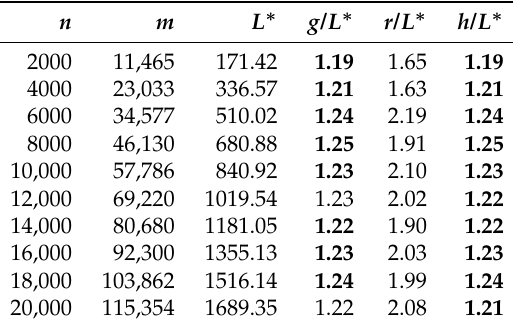
Table 2. Results for 5-Planar Graphs.